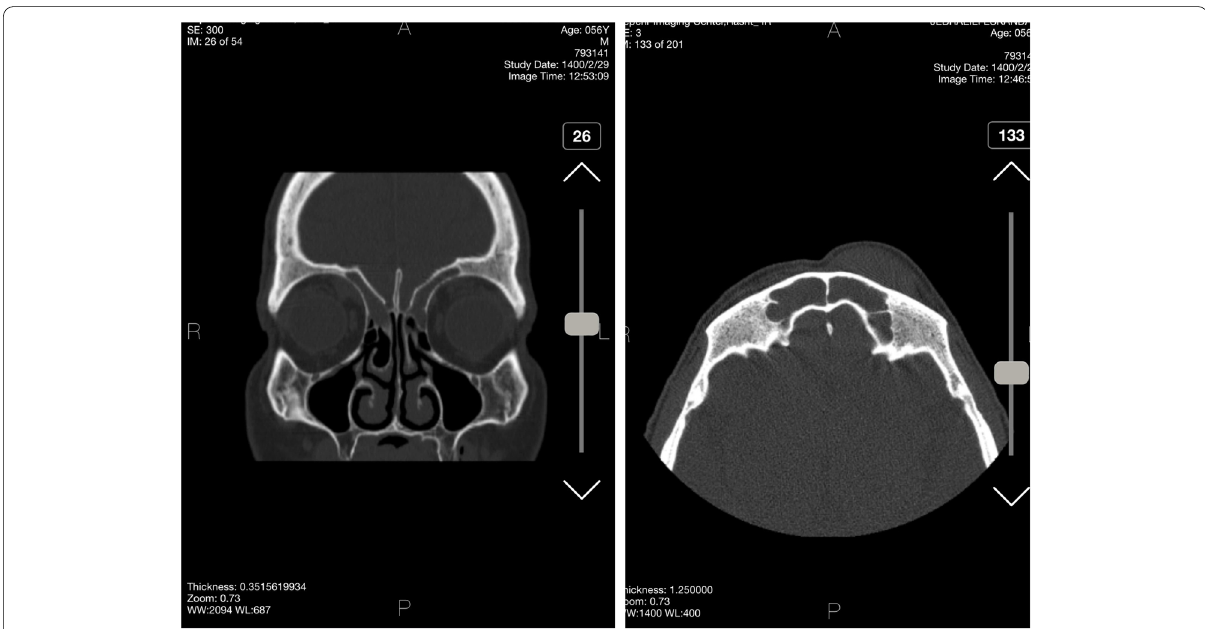
Fig. 2 Coronal and axial views of paranasal sinus CT scan of the